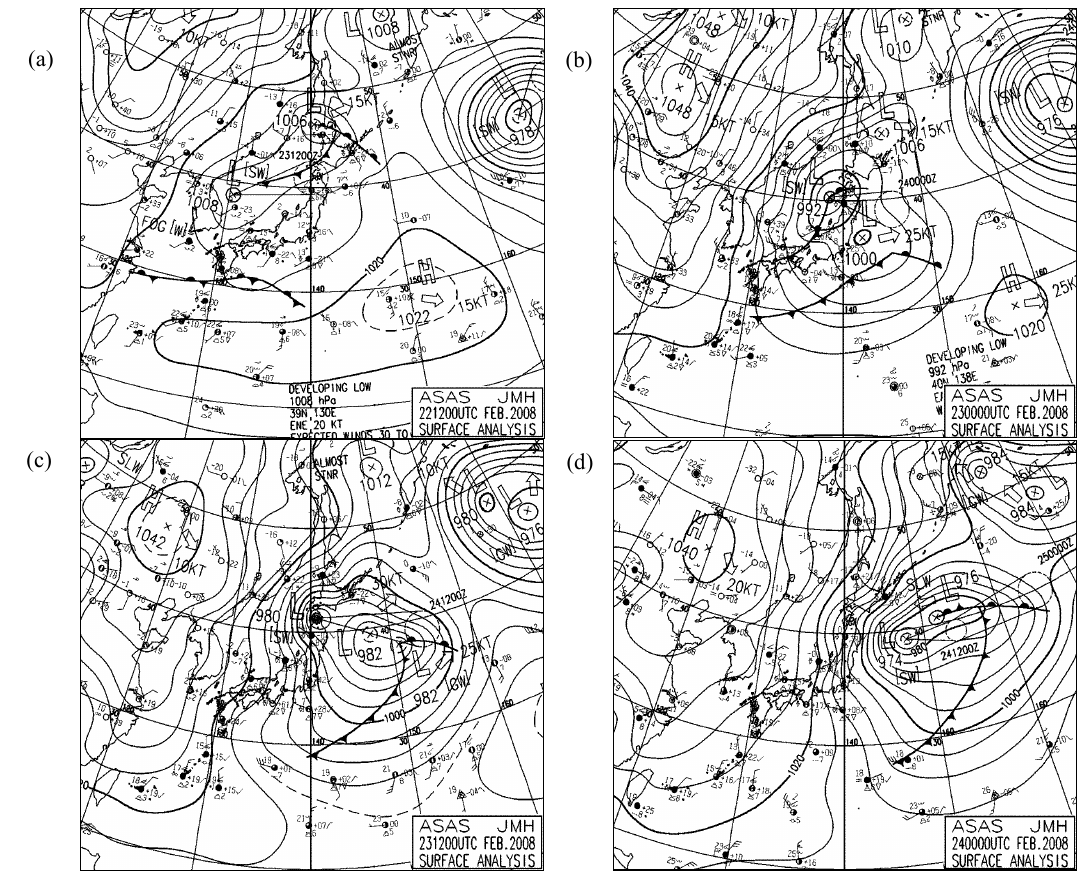
Fig. 11. Weather charts for twelve hour increments from 12:00UTC 22 February to 00:00UTC 24 February 2008 (from JMA).